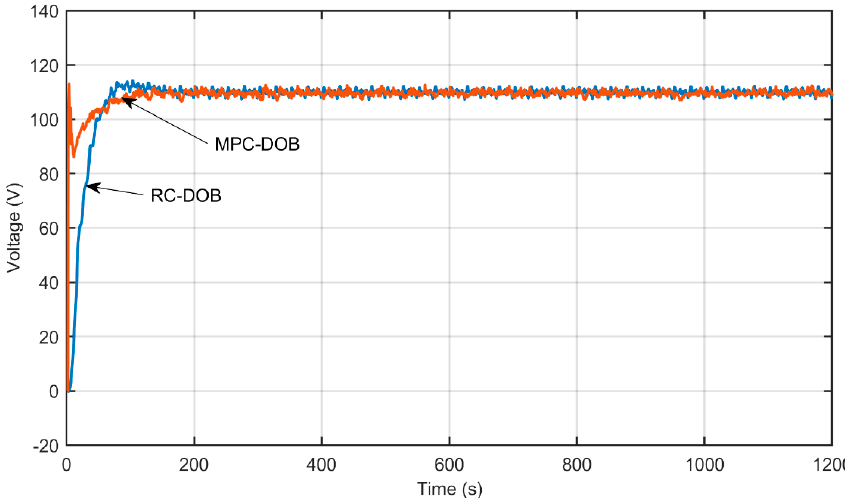
Figure 16. Transient response of MPC-DOB and RC-DOB under the nonlinear load with different filter parameters ( (cid:2015) = 7.5) .